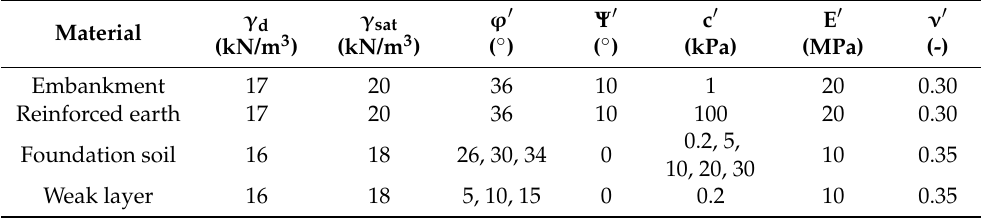
Table 2. Geotechnical parameters of materials used in the numerical analyses. γ d : dry unit weight; γ sat: saturated unit weight; c ′ : effective intercept cohesion; φ′ : effective shear strength angle; Ψ′ : dila- tion angle; E ′ : Young modulus; ν′ : Poisson’s ratio. The elastic – perfectly plastic Mohr – Coulomb con- stitutive model was used for all modelled soils.